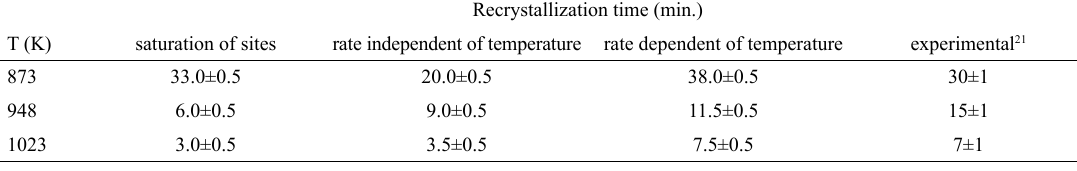
Table 2: Experimental and simulated results for primary recrystallization times of CP titanium, at each considered temperature and for each nucleation mechanism. Recrystallization time (min.)